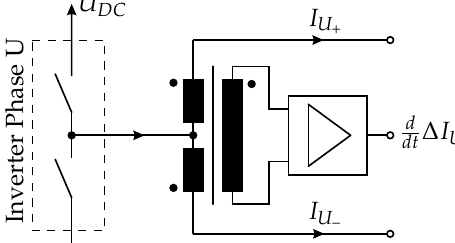
Figure 2. Differential current slope measurement by means of a differential open loop